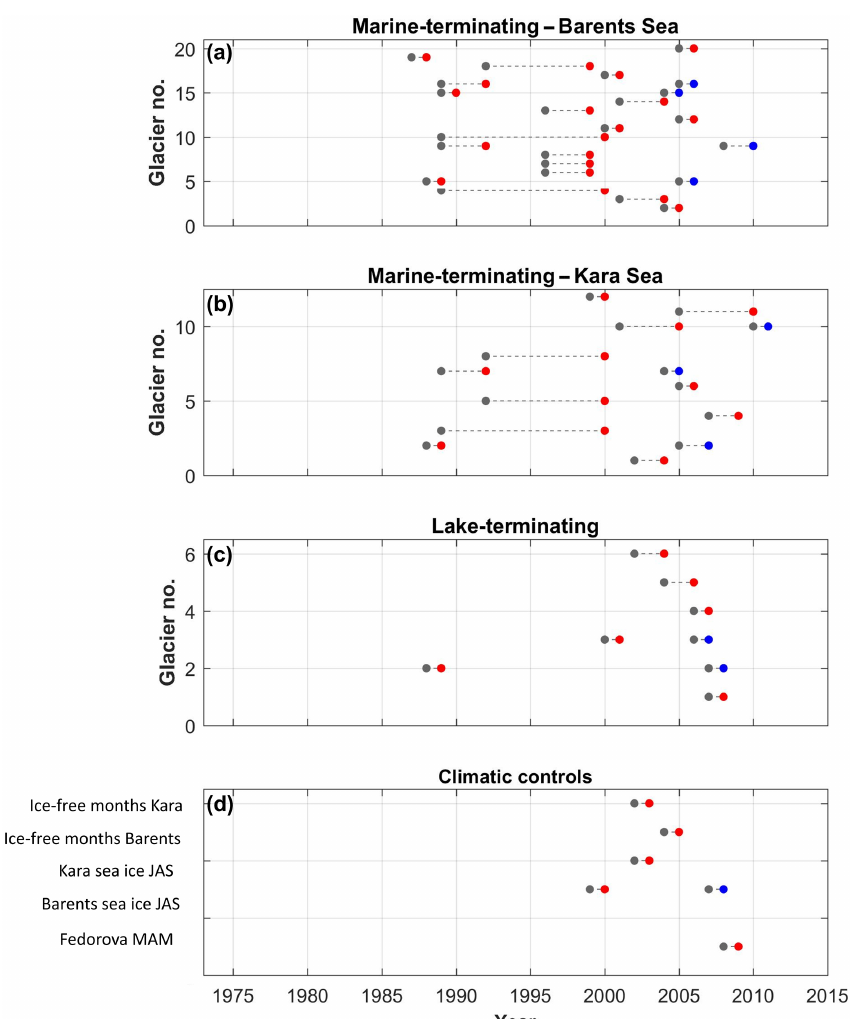
Figure 6. Results of the change-point analysis for glacier retreat rates and climatic controls. Red dots indicate the start of a significantly different period in the time series data, and grey dots represent the end of the previous period, with grey dashed lines connecting the two. This is done to account for missing data: we know that the change-point occurred between the grey and the red dot, and that the new phase of behaviour occurred from the red dot onwards, but not the exact timing of the change. Blue dots show the start of a second significant change in the time series. Frontal-position data were analysed separately for marine-terminating outlets on the Barents Sea coast (a) , Kara Sea coast (b) , and lake-terminating glaciers (c) . (d) Change-point results for seasonal means in air temperatures and sea ice, and the number of ice-free months. Only climatic variables that demonstrated change-points are